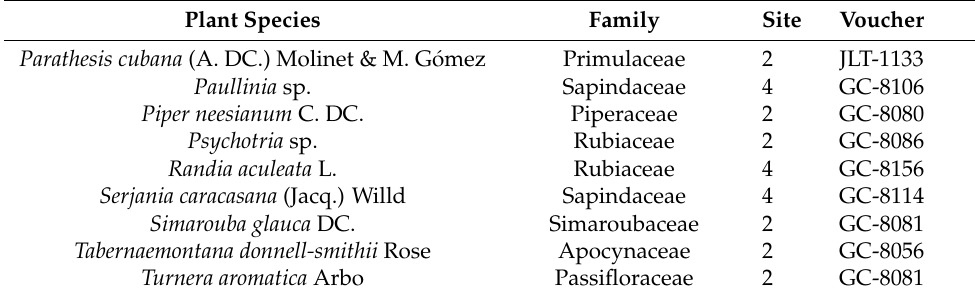
Table 2. Nematicidal effects of aqueous extracts from native plants of the Yucatan Peninsula against second-stage juveniles (J2) of Meloidogyne incognita and M . javanica after 72 h of exposure.